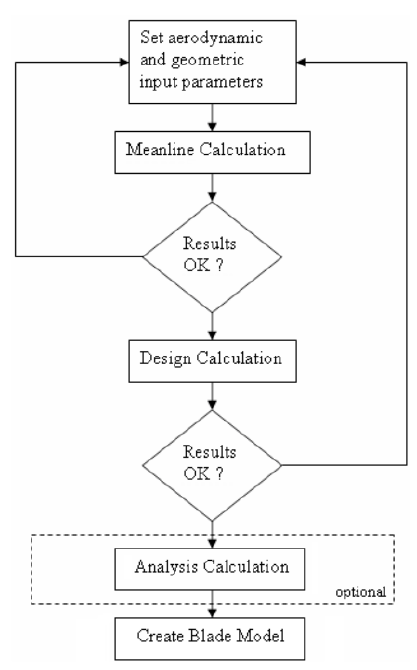
Figure 8. Flow chart of the LPC aerodynamic design procedure.